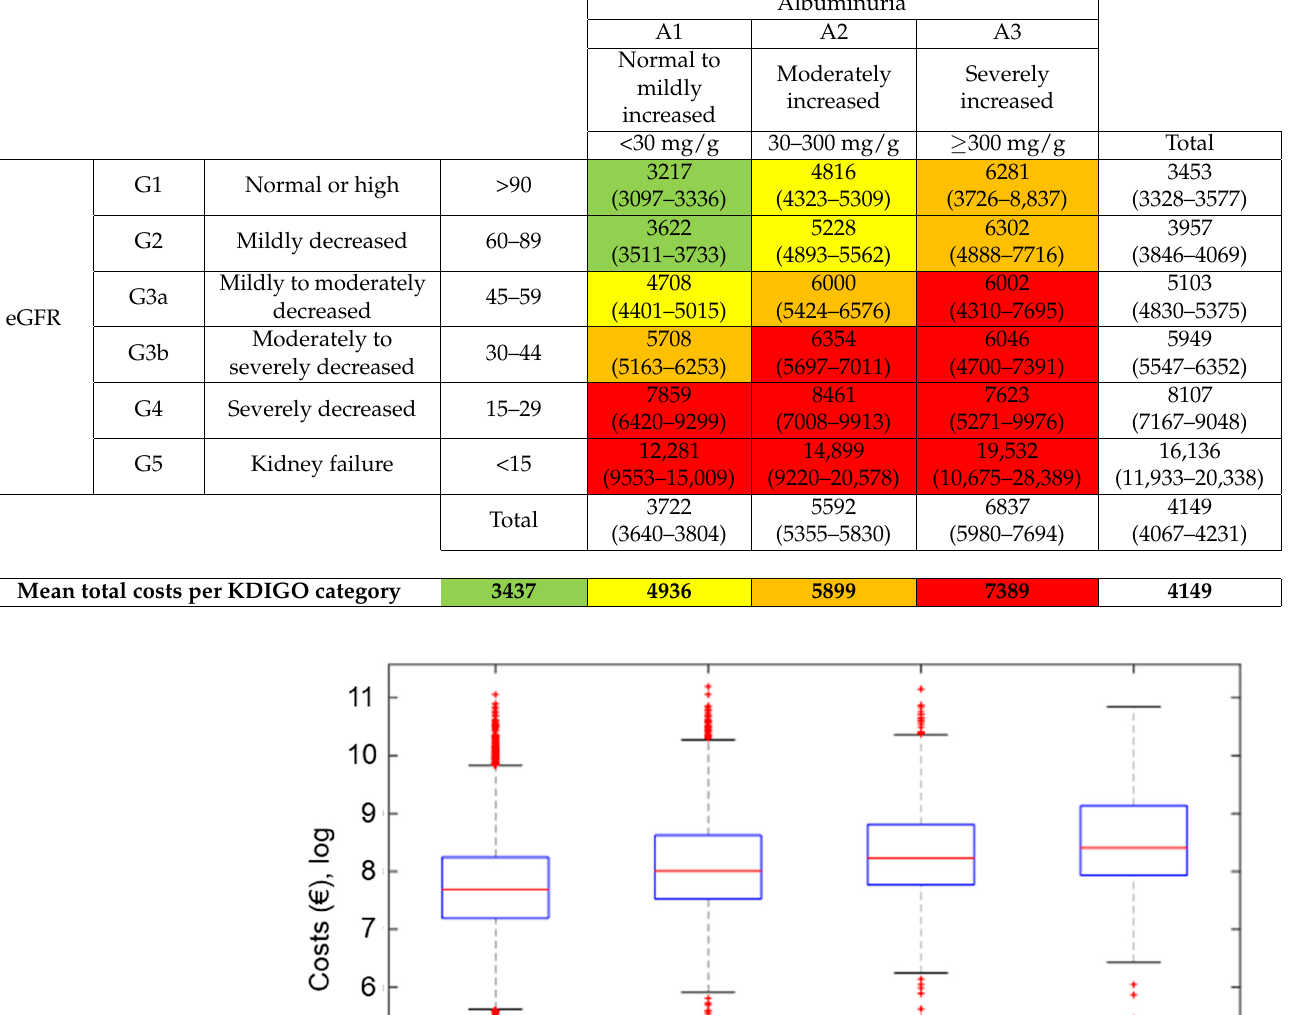
Table 4. Mean (CI 95%) costs per patient associated to each KDIGO category (EUR).